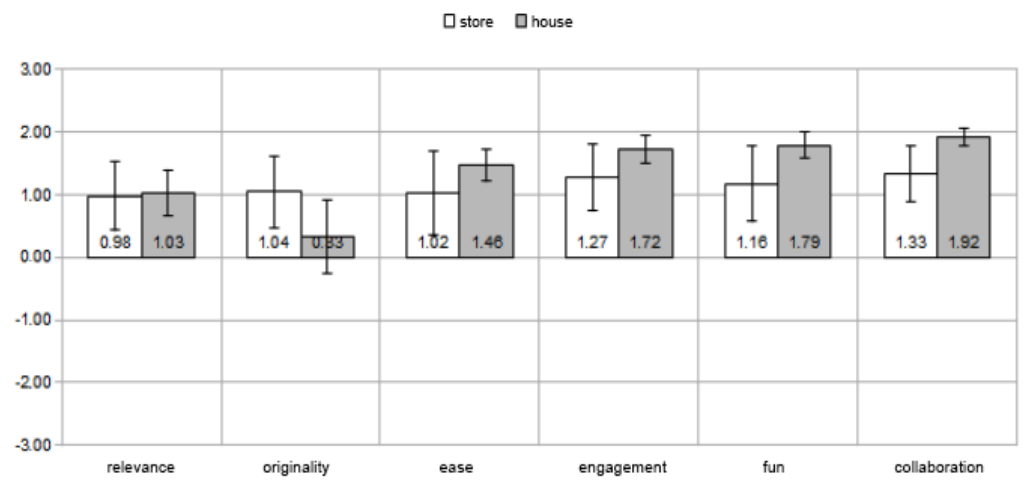
Figure 6. Results: men (grey) and women (white). Bars represent average and lines indicate the standard